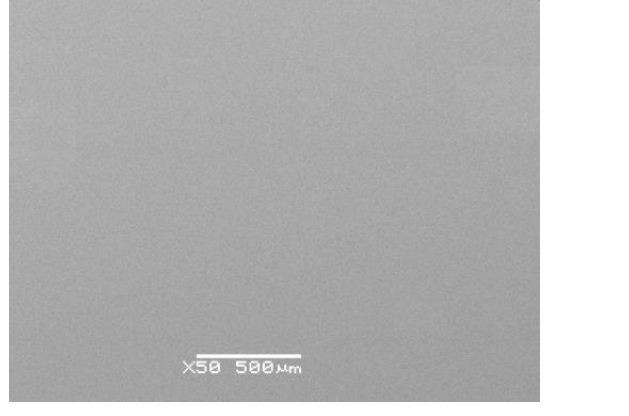
Figure 8. View of the surface of a polymethyl methacrylate PMMA specimen prior to the applica- tion of a paint coating and prior to high-pressure water-ice jet treatment: ( a ) Scanning electron mi- croscope image (50×magnification); ( b ) Isometric image.